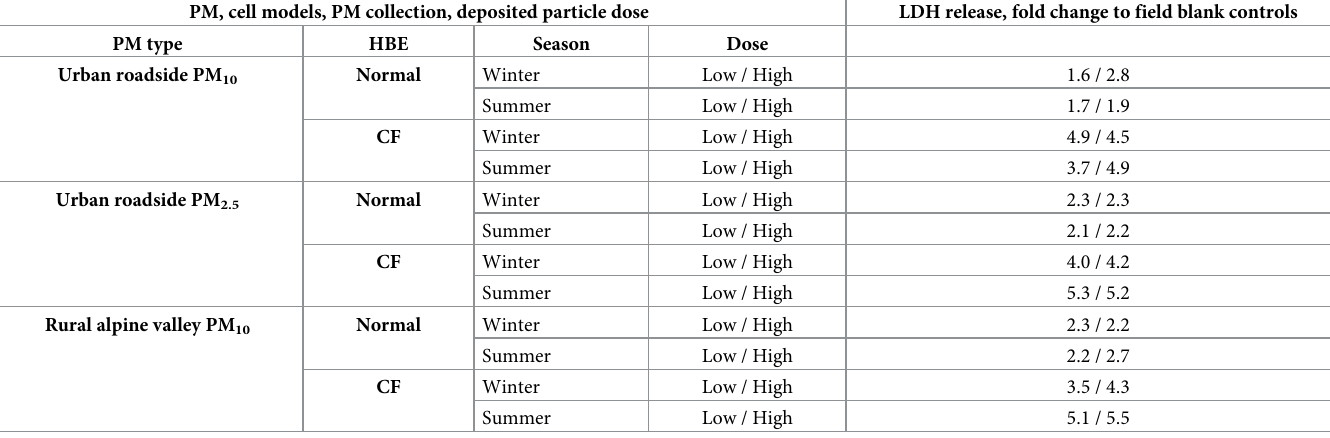
Table 2. Cytotoxicity in normal and cystic fibrosis (CF) human bronchial epithelia (HBE) after exposure to PM. PM, cell models, PM collection, deposited particle